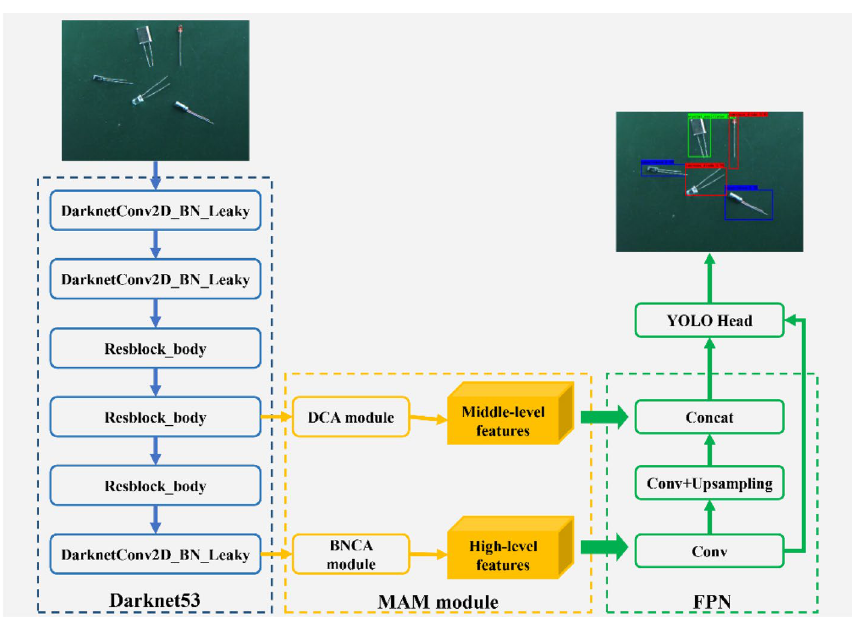
Figure 5. Improved YOLOv4-tiny architecture. Only the MAM is added, and the rest of the network structure remains unchanged. The structure of CSPdarknet53 adopts the original YOLOv4-tiny network